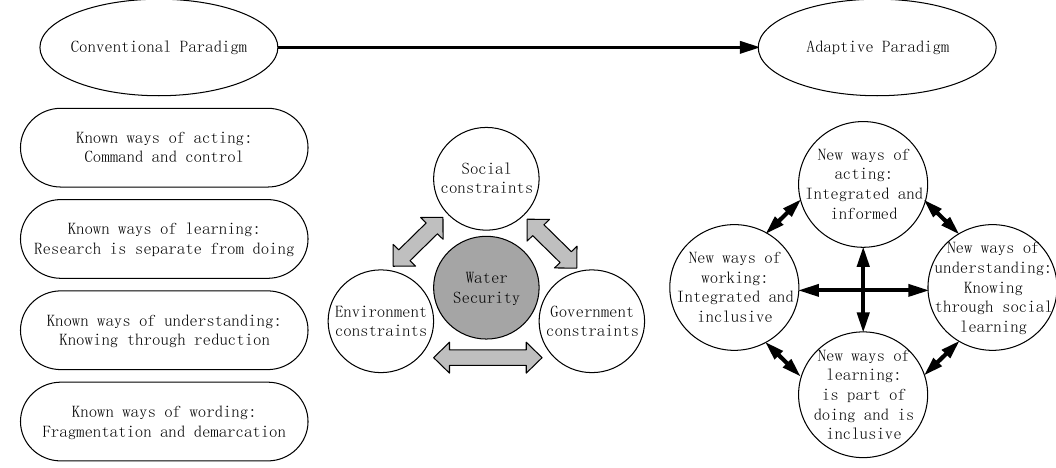
Figure 8. Comparison between conventional paradigm and adaptive paradigm.